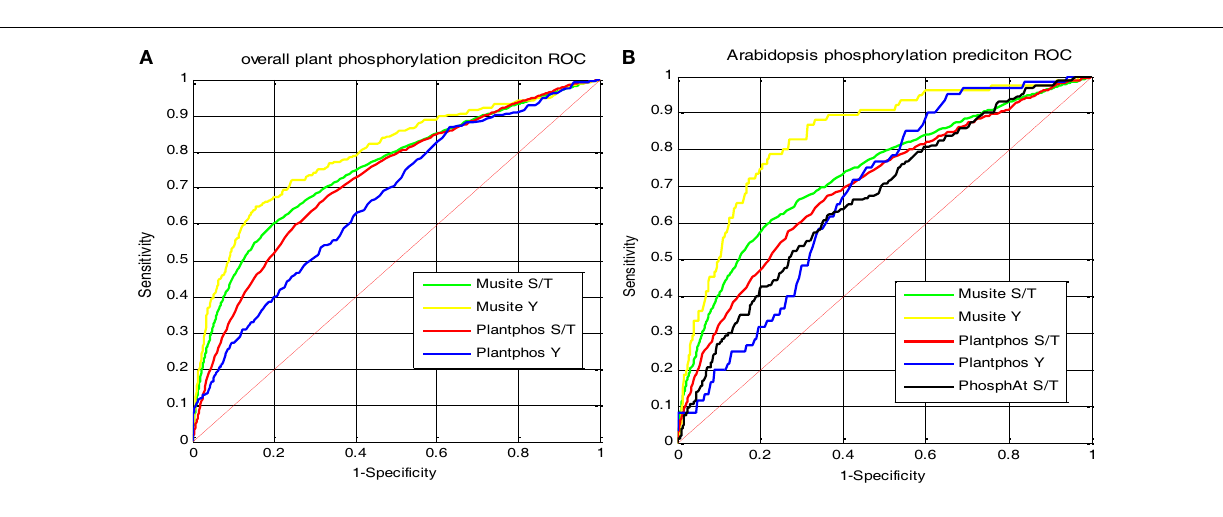
phosphorylation data, in comparison with Plantphos; (B) testing result on Arabidopsis only from the dataset in (A) in order to compare with